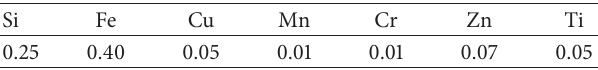
Table 1: Chemical composition of the experimental material in